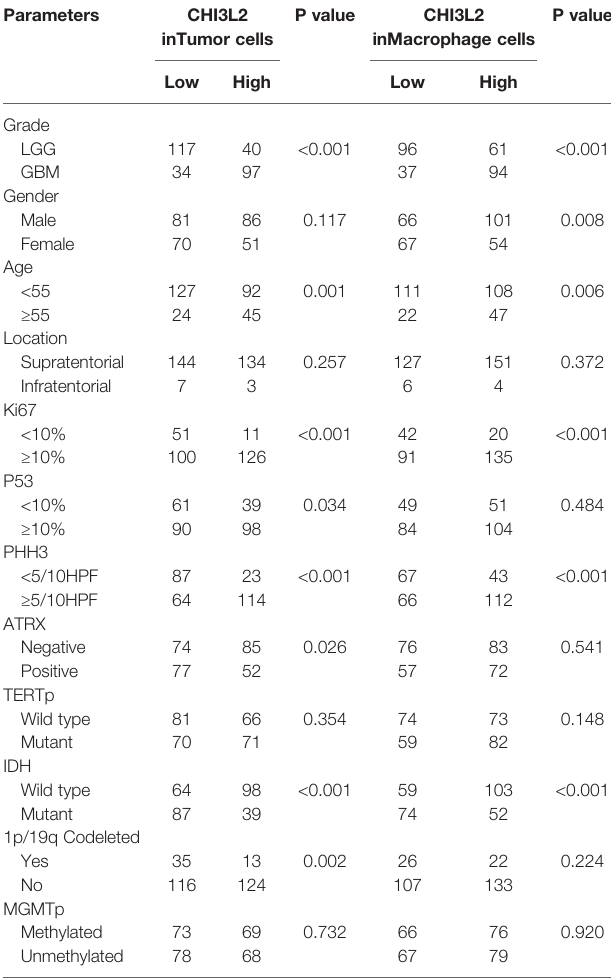
TABLE 1 | Correlation between CHI3L2 expression and clinicopathologic parameters in gliomas.